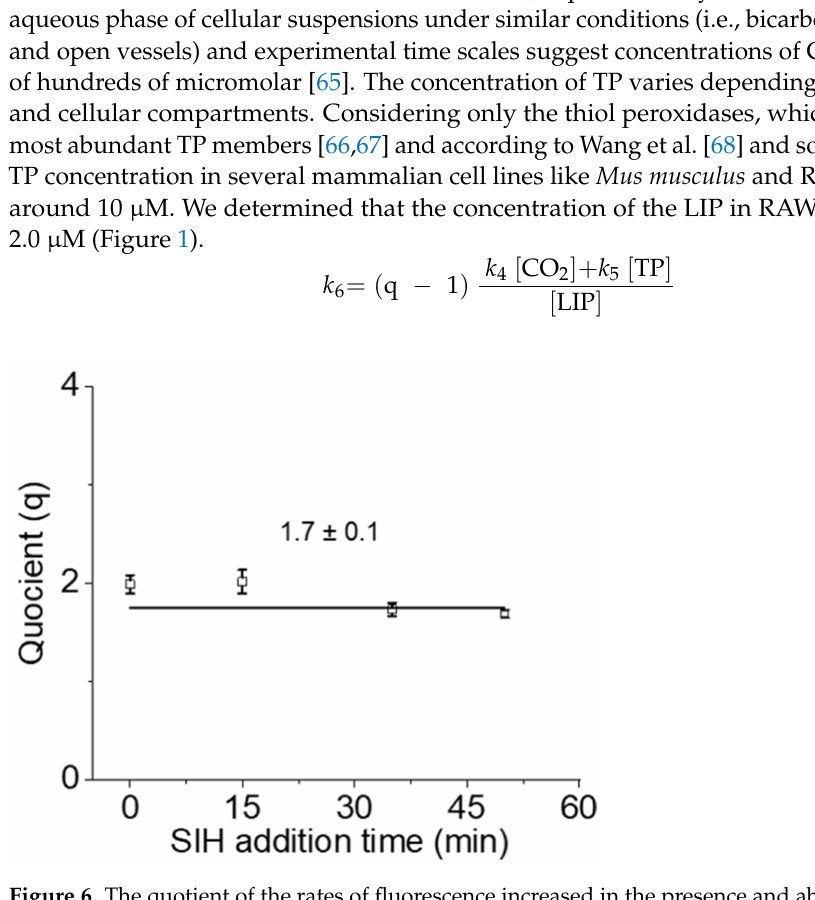
Figure 6. The quotient of the rates of fluorescence increased in the presence and absence of SIH. The quotient (q) was determined by dividing the rates of the increase in fluorescence in the presence of SIH by the rates of the increase in fluorescence in the absence of SIH; the data from Figure 5 were